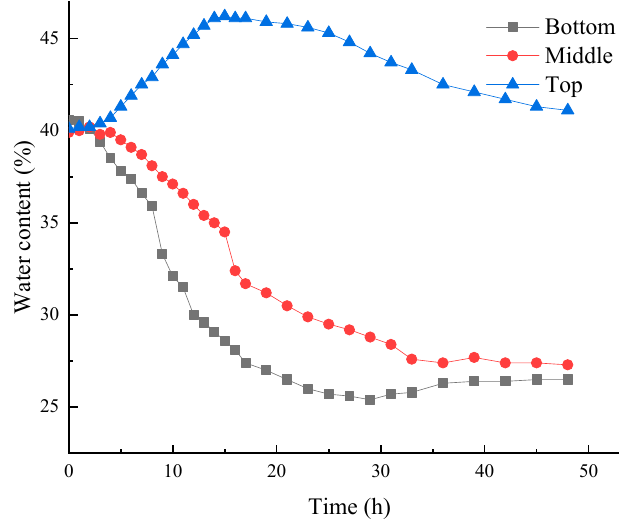
Figure 6. Water flow in electro-osmosis.